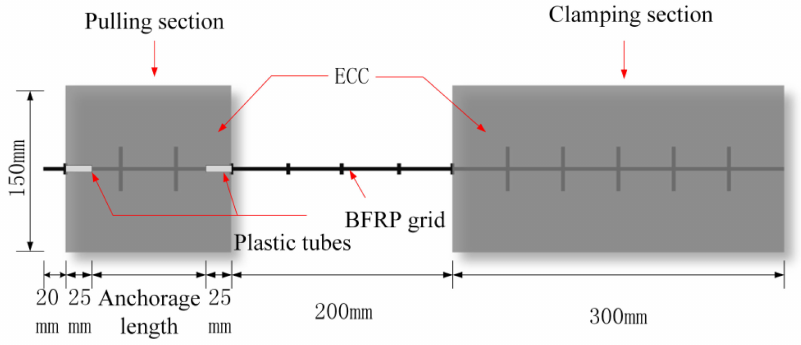
Figure 1. BFRP grid and ECC drawing sample design schematic diagram.